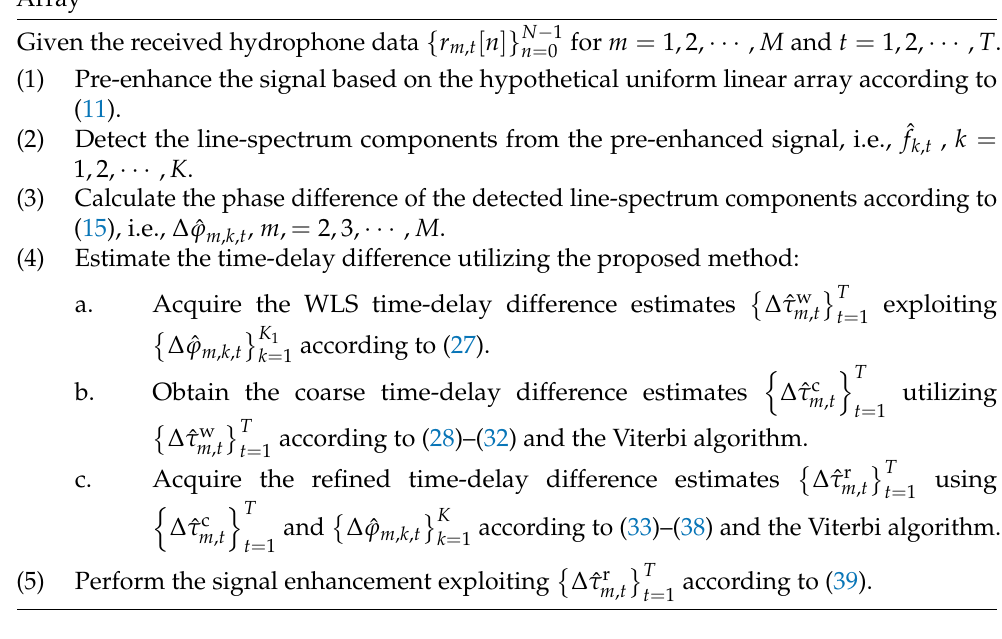
Algorithm 1 Summary of the Signal Enhancement in the Distorted Towed Hydrophone